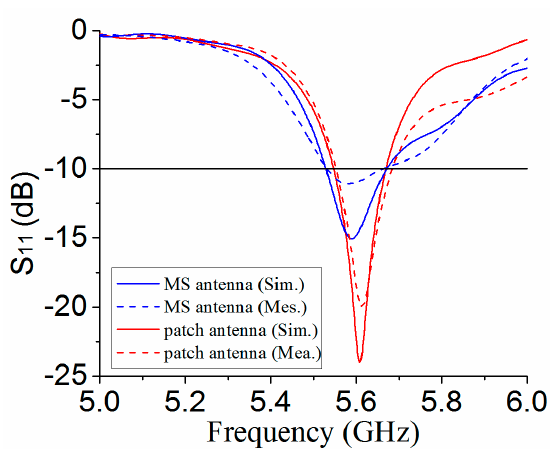
Figure 10. Simulated and measured S 11 for patch antenna and MS antenna.